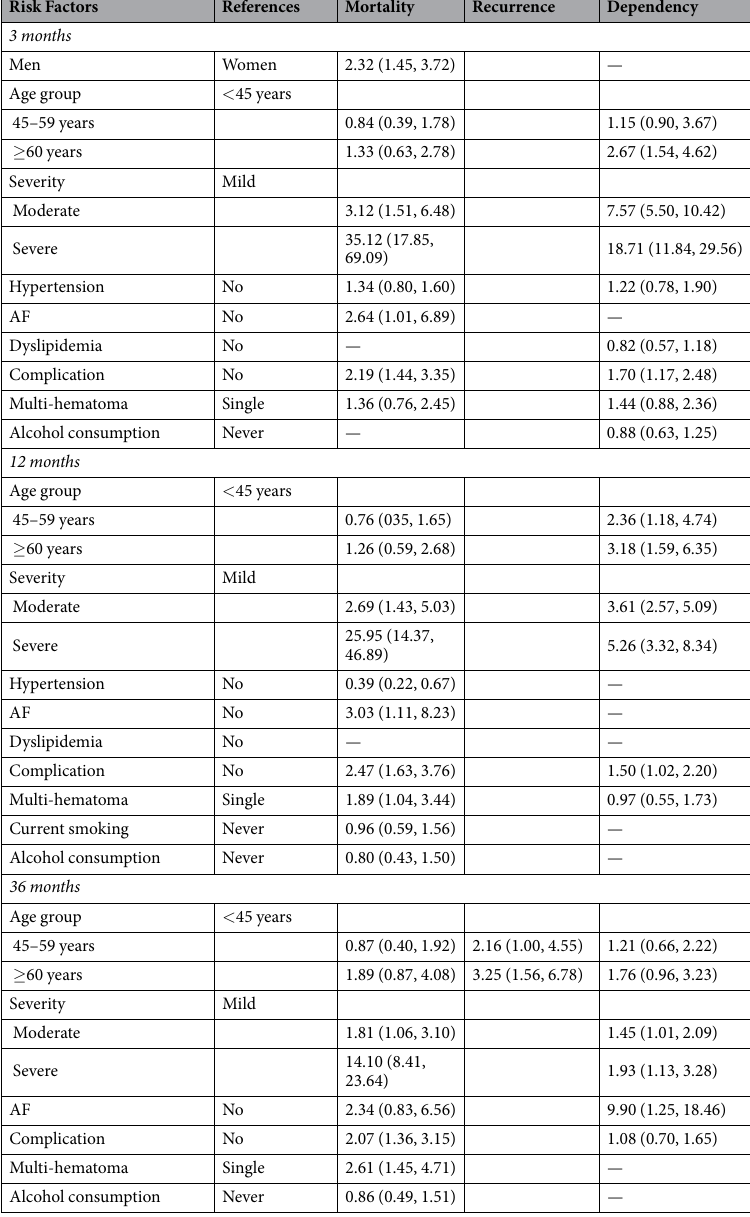
Table 3. Adjusted OR (95% CI) for associated factors of outcomes at 3, 12, and 36 months after